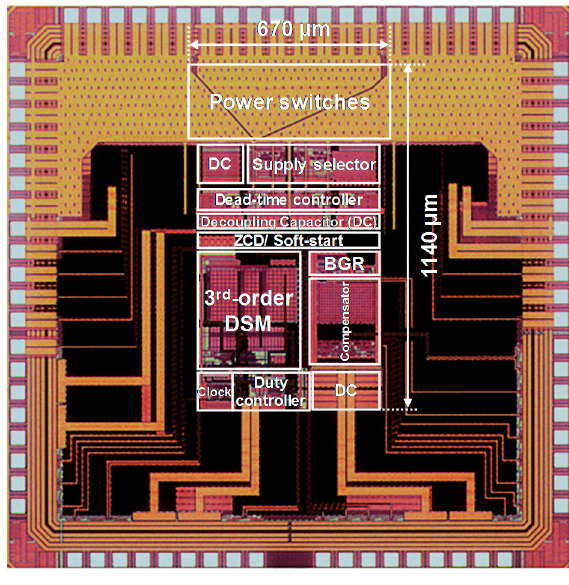
Figure 9. Chip micrograph.